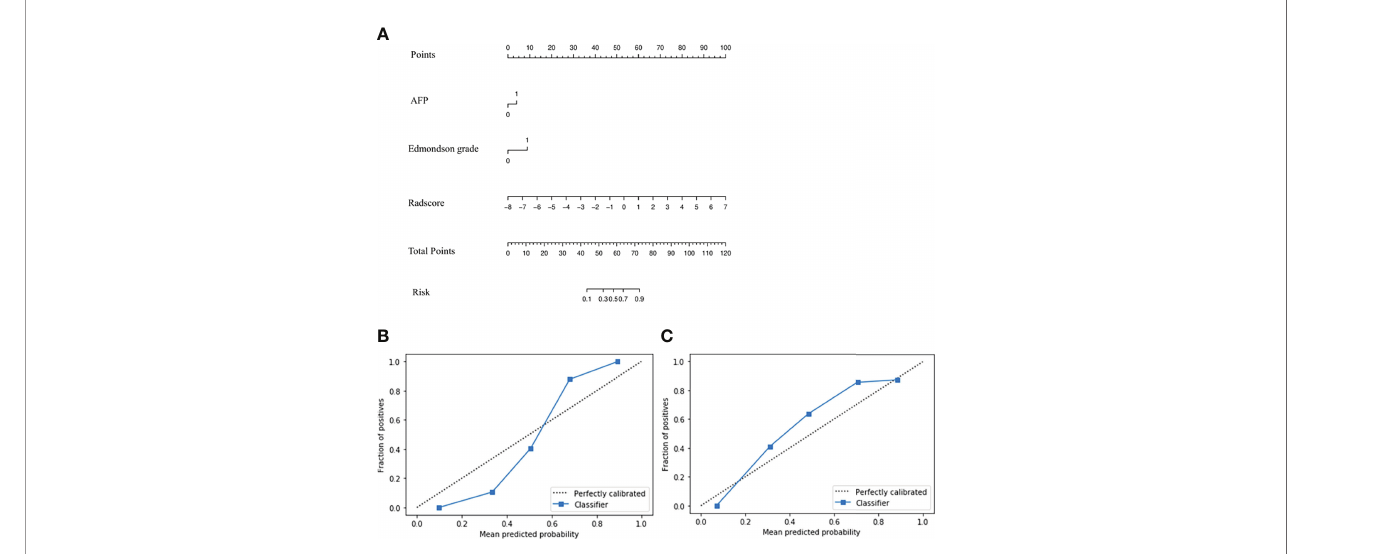
FIGURE 5 | Radiomics nomogram (A) Calibration curve of the radiomics nomogram in training (B) and validation groups